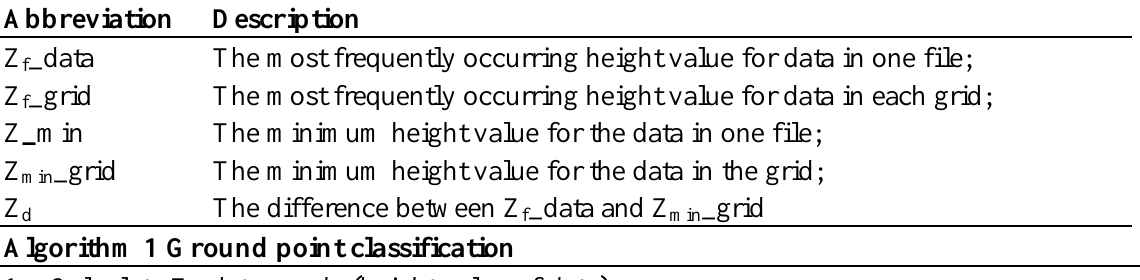
Algorithm 1 Ground point